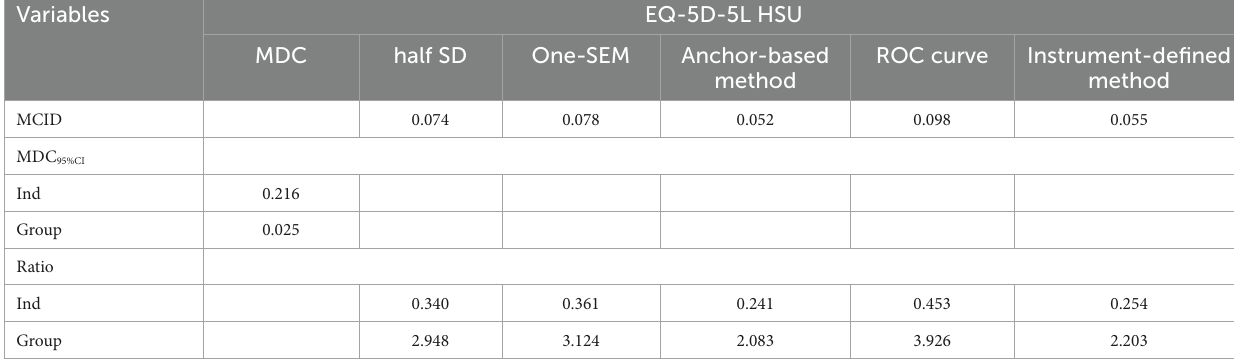
EQ-5D-5L, five-level EuroQoL five-dimensional questionnaire; HSU, health state utility; MDC, minimal detectable change; SD, standard deviation; SEM, standard error measurement; ROC, receiver-operating characteristic; 95%CI, 95% confidence interval.